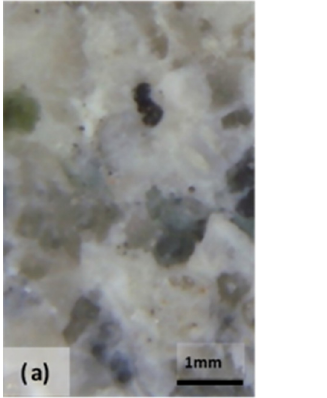
Figure 8. Specimen P3.1 (Bateig Crema Maroc) subjected to microscopic analysis using the Pancellent wireless digital optical microscope.